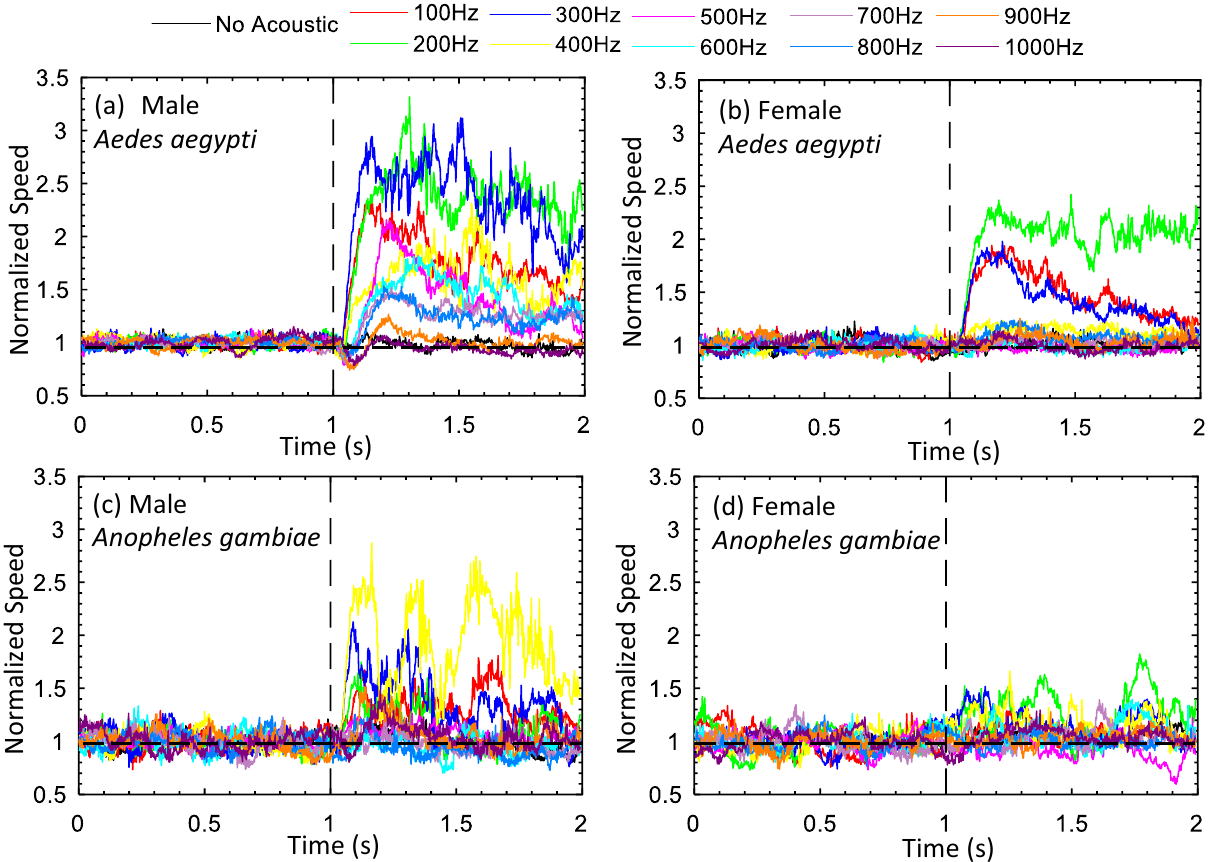
Figure 1. Acoustic wave effect on the flight speed of flying mosquitoes at different frequencies at a sound intensity of 103 dB. The flight speed results were normalized by the average speed obtained during the 1st second in each test. ( a ), ( b ), ( c ), and ( d ) were normalized flight speeds of male and female Aedes , and male and female Anopheles , respectively.